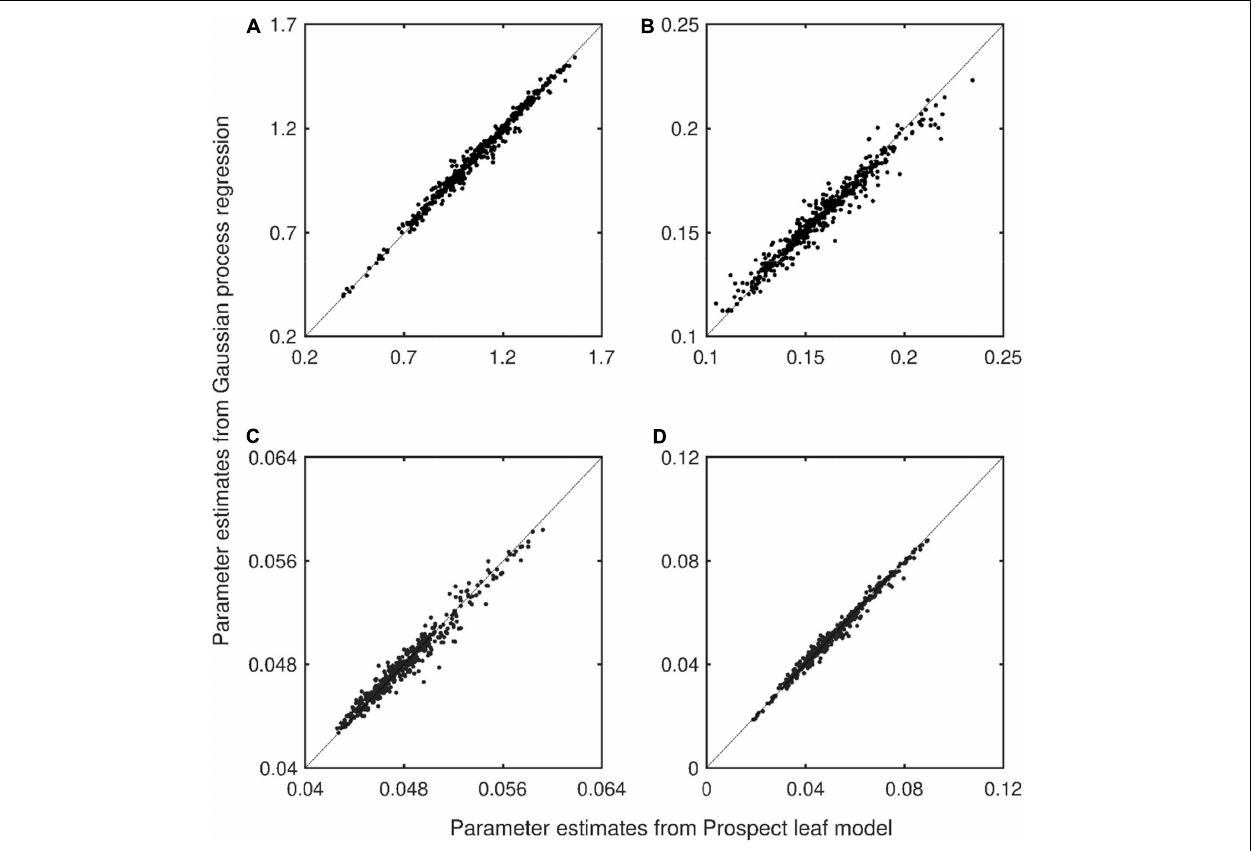
FIGURE 3 | Estimated parameters from the Prospect model (using Equations 1–4) vs. empirical regression estimates using Gaussian process regression y = f( Chl, LMA, Car ) with 1:1 line. n = 470, Lopex and Angers leaf optical properties datasets, (A) scaling parameter p 1 , (B) effective leaf extinction coefficient k , (C) absorption coefficient k a , and (D) the product of p 1 and k a . Optical depth is the chlorophyll content ( Chl ; µ g/cm 2 ).